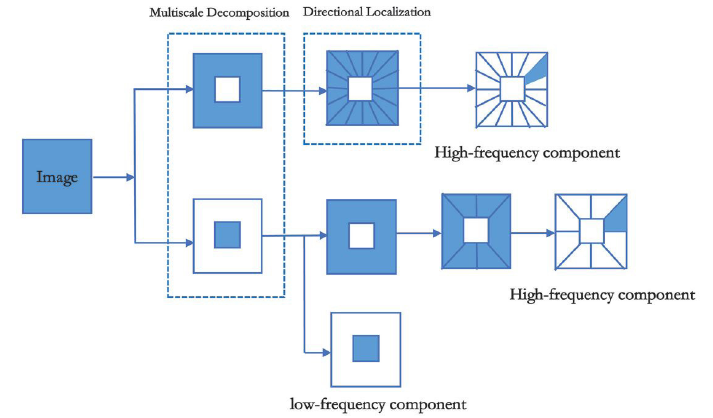
Figure 2. Decomposition process of non-subsampled shearlet transform